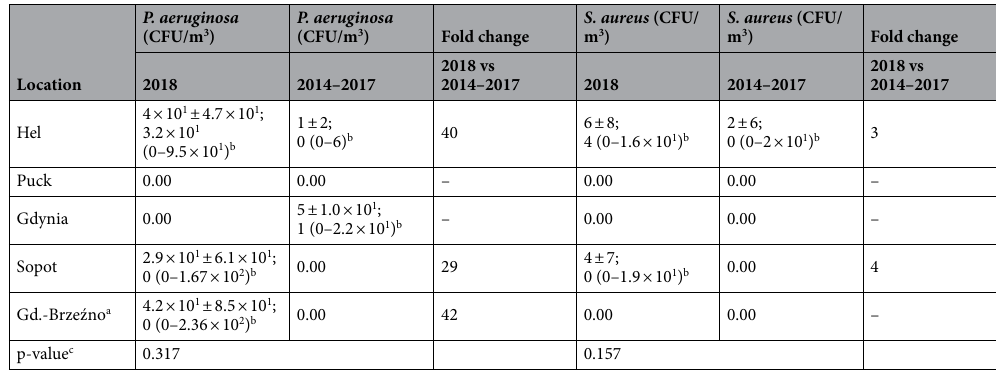
Table 6. The mean and standard deviation of concentration of P. aeruginosa and S. aureus (CFU/m 3 ) in air over the Bay of Gdańsk in 2018 versus 2014–2017. a Gd.-Brzeźno—it is an abbreviation of the town name Gdańsk-Brzeźno, b in case of a higher standard deviation than the mean, the median and range (min–max) was calculated, c Friedman test,